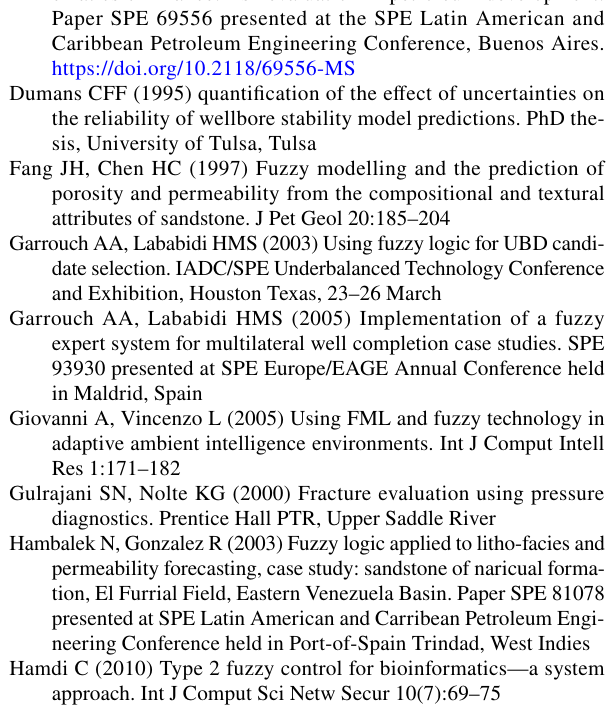
Fig. 6 a Predetermined fuzzy inference system solution from rule viewer. b 3D graphical fuzzy inference solution from rule